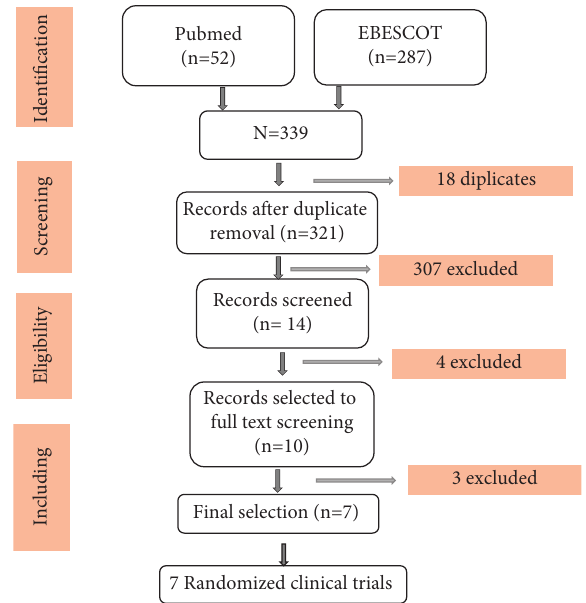
Figure 1: PRISMA flowchart of the study selection